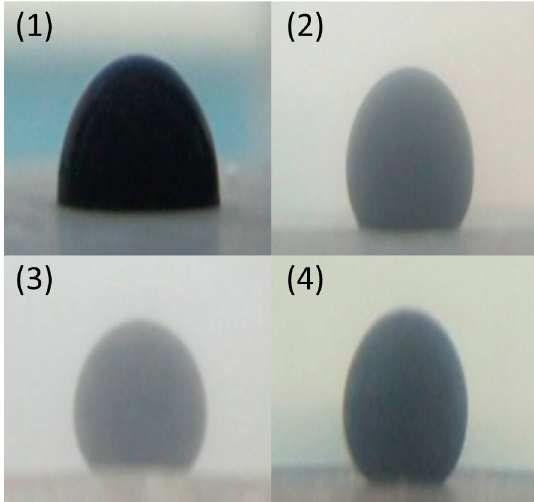
Figure 15. Microscopic images of oil droplets (flipped image) at 26 °C in the presence of brine ( 1 ), Al 2 O 3 nanofluid ( 2 ), TiO 2 nanofluid ( 3 ), and SiO 2 nanofluid ( 4 ). Figure reproduced from Ref.